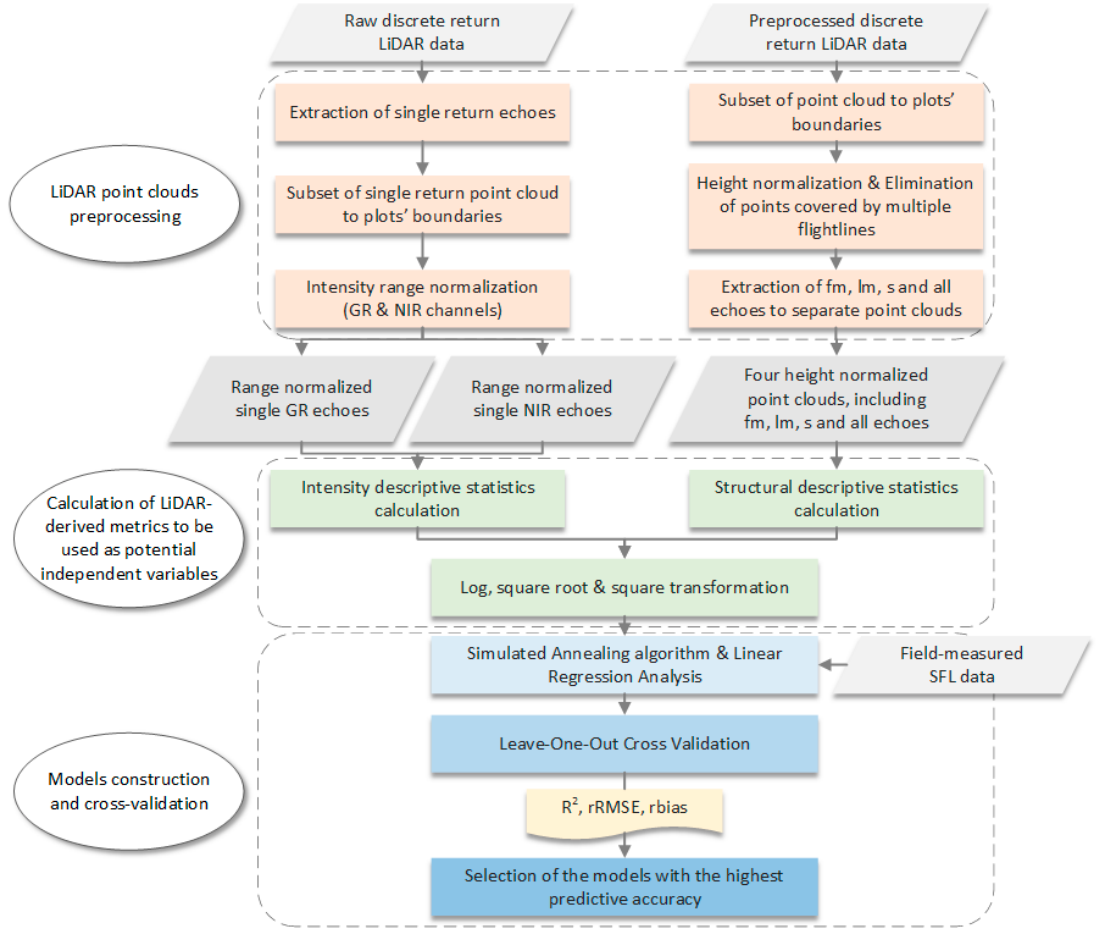
Figure 2. Flowchart of the workflow employed for the Light Detection and Ranging (LiDAR)-based estimation of surface fuel load (SFL) through Simulated Annealing and multiple linear regression analysis (fm, lm, and s stand for the first-of-many, last-of-many, and single returns, respectively; GR and NIR represent the Green and Near Infrared channels).